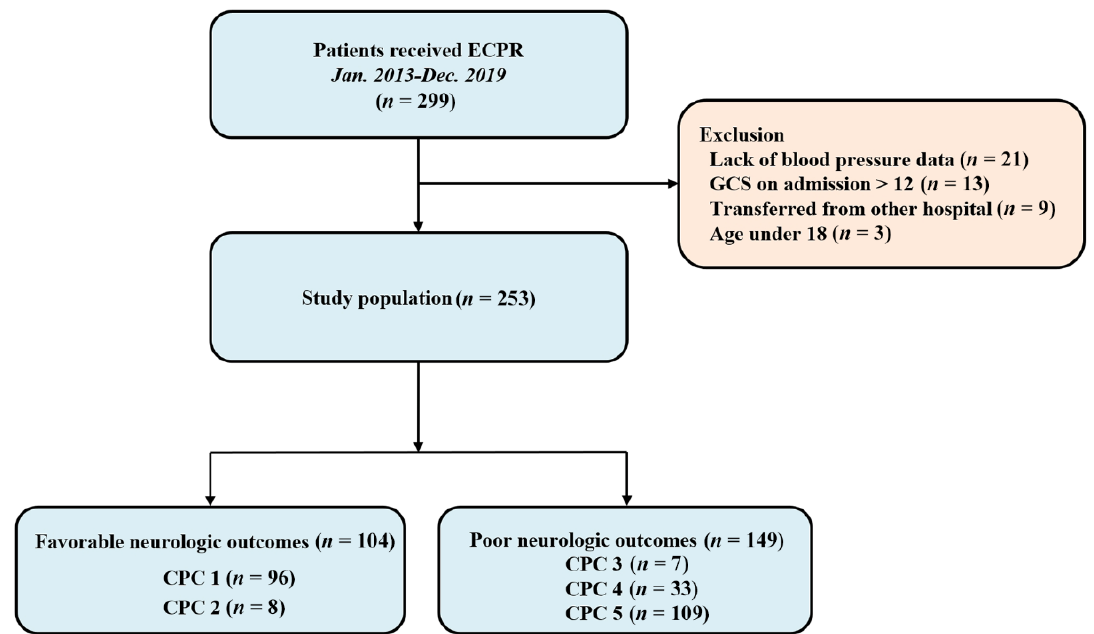
Figure 1. Study flow chart. ECPR, Extracorporeal Cardiopulmonary Resuscitation; GCS, Glasgow Coma Scale; CPC, Cerebral Performance Category.